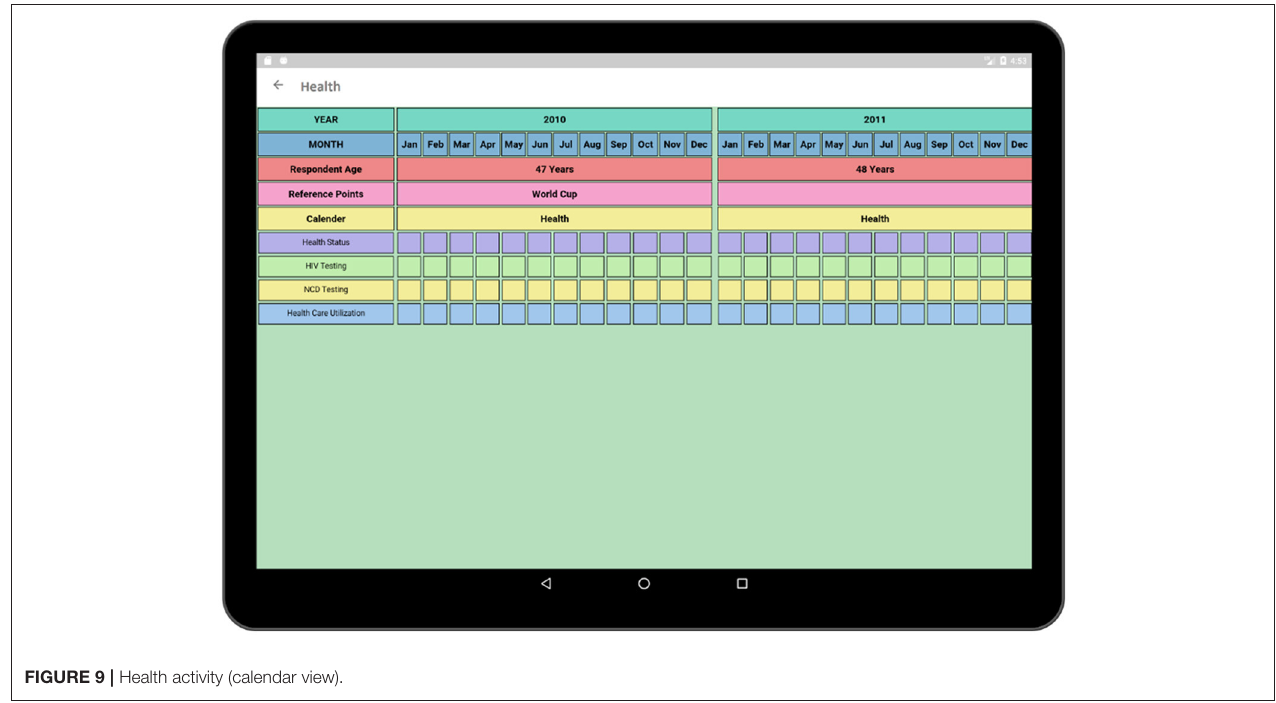
FIGURE 9 | Health activity (calendar view).